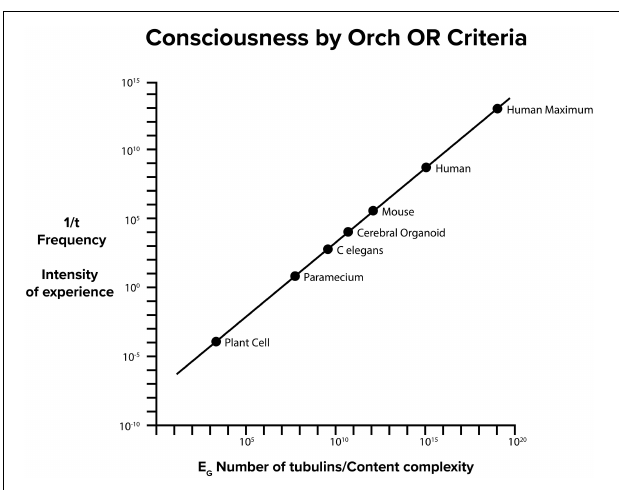
FIGURE 9 | Consciousness by Orch OR criteria E G = è /t. On the Y axis, 1/t frequency in Hz of Orch OR events also indicates intensity of experience, On the X axis, E G and number of tubulins also indicate information content capacity of conscious